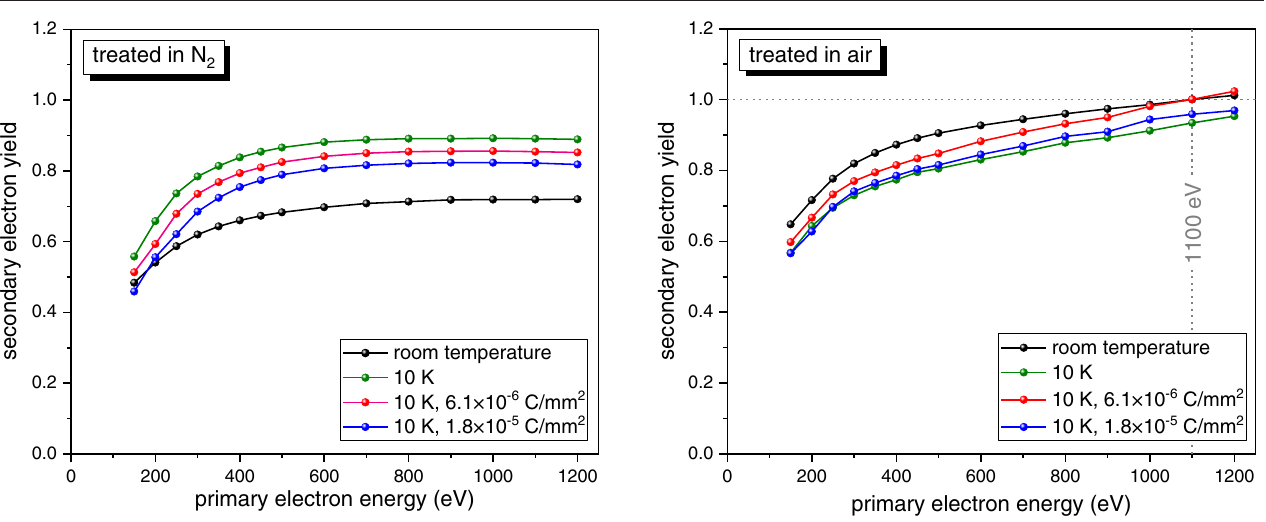
FIG. 10. SEY measurements of a LH-patterned sample treated in air: at room temperature (black line), at ≈ 10 K (green line), and after exposure to an electron dose of 6 . 1 × 10 − 6 (red line) and 1 . 8 × 10 − 5 C mm − 2 (blue line). The energy for which the SEY increases above unity is indicated.